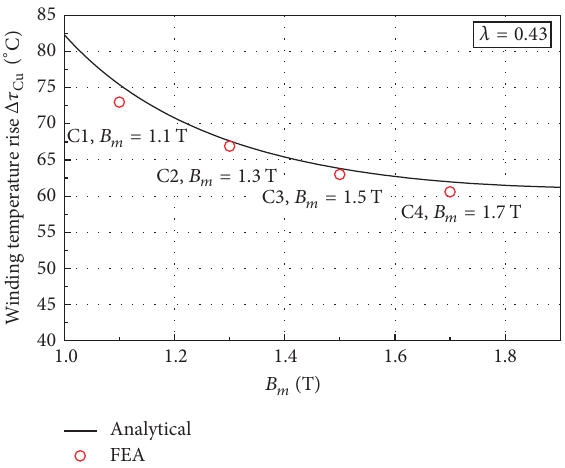
Figure 5: FEA verifications of the designs C1, C2, C3, and C4.